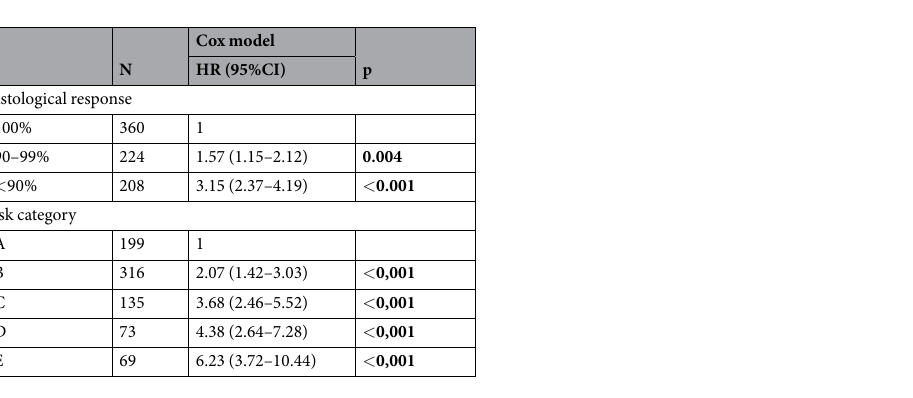
Table 6. Cox model for overall survival from surgery. Hazard ratio (HR) along with 95% confidence interval (CI) (n =